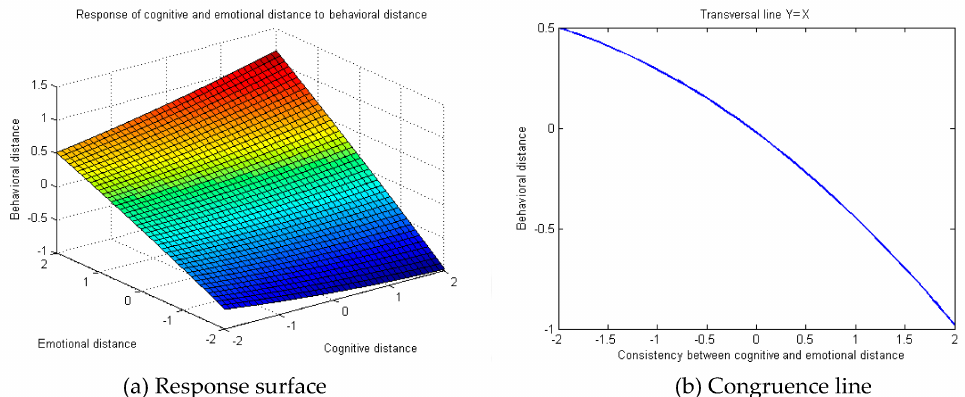
Figure 3. Response diagram of public cognitive and emotional distance towards occupational safety and health against behavioral distance.